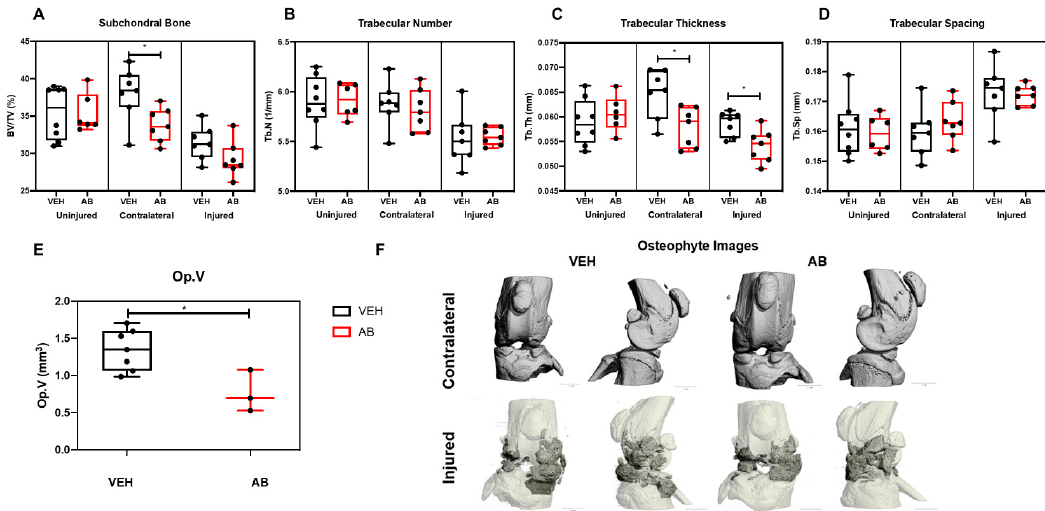
Figure 2. Bone phenotype of antibiotic-treated injured mice. ( A ) Subchondral trabecular bone volume fraction (BV/TV) of the distal femoral epiphysis. ( B ) Trabecular number was measured using the average number of trabeculae per unit length. ( C ) Trabecular thickness was measured using the mean thickness of trabeculae assessed using direct 3D methods. ( D ) Trabecular spacing was measured using the mean distance between trabeculae, assessed using direct 3D methods [38]. ( E ) Osteophyte volume at six weeks post injury. ( F ) Osteophyte imaging using µCT. (* p < 0.05).